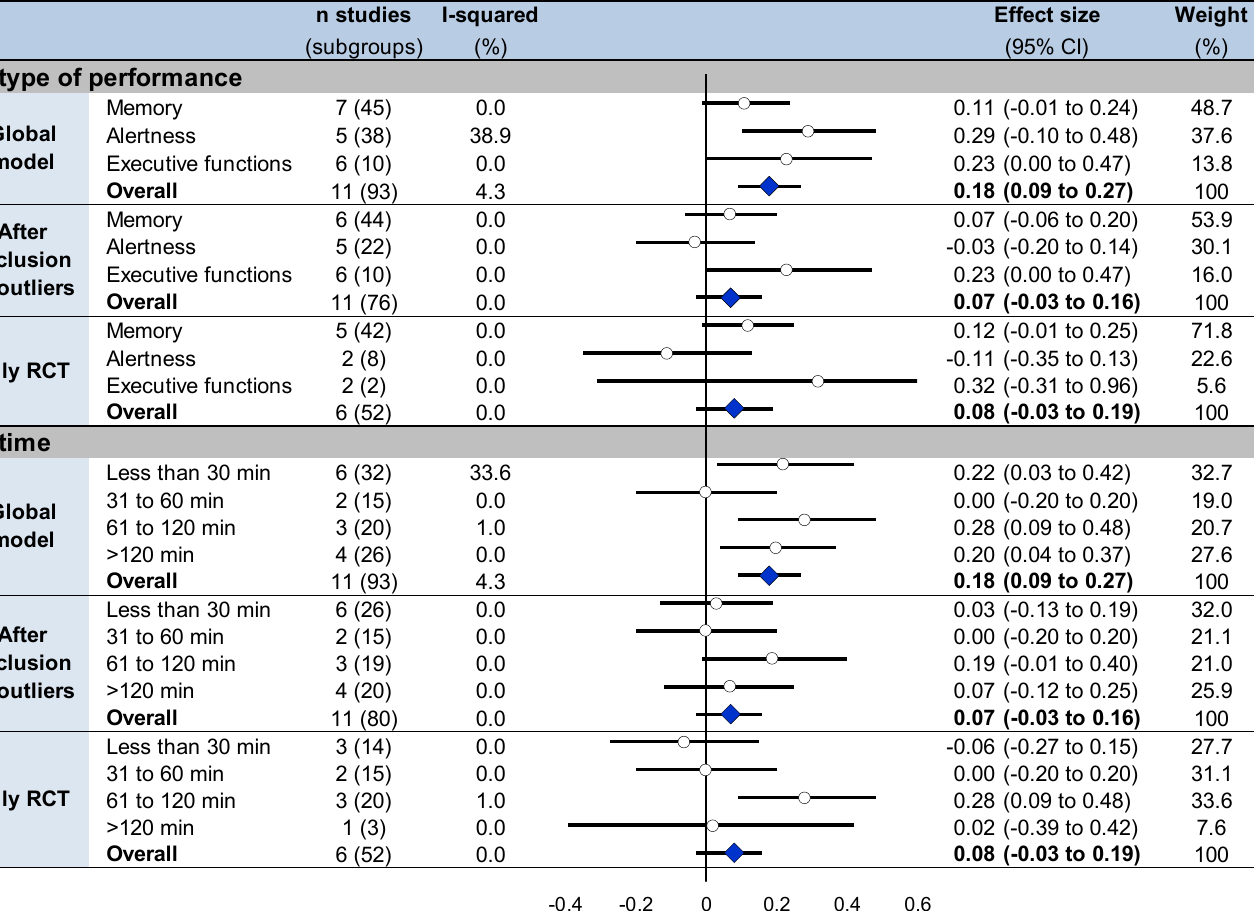
Figure 4. Summary of meta-analyses on cognitive performance stratified on type of cognitive function and on time of analysis at t1 between groups. Each summary of meta-analysis is presented in three conditions: global model with all the studies, after exclusion of outliers (studies not evenly distributed around the funnel plot) and with only randomized controlled trials. Each summary of several meta-analyses is represented in the forest plot by a dot on a horizontal line. The black dots represent the pooled-effect estimate (pooled effect size—ES), and the length of each line around the dots represents their 95% confidence interval (95CI). Shorter lines represent a narrower 95CI thus higher precision around pooled-ES. Conversely, longer lines represent a wider 95CI and less precision around pooled-ES. An overall summary of the results of the meta-analyses pooled-estimate (result of the overall meta-analysis) is represented by a blue lozenge at the end of the graph. The black solid vertical line represents the null estimate (with a value of 0 for pooled-ES). Horizontal lines that cross the null vertical line represent the non-significant overall summary of the meta-analysis. Bold numbers represent the overall result of each meta-analysis.